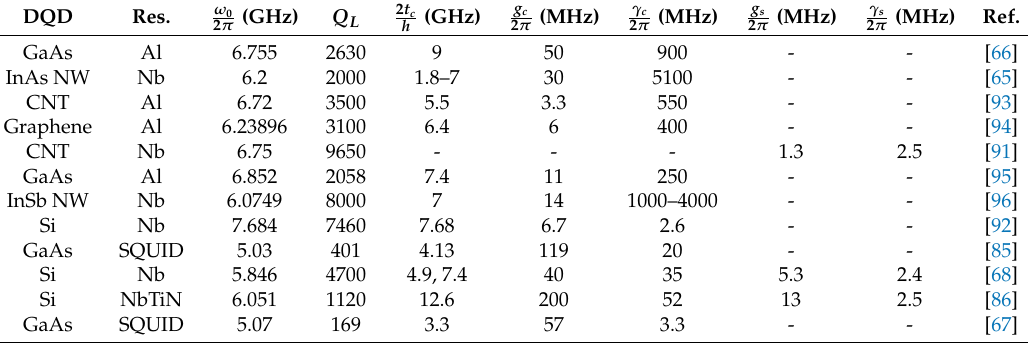
Table 1. Summary of the typical parameters reported for different DQD devices coupled to superconducting planar resonators. DQD Res. ω 0 (GHz) Q L 2 t c (GHz) g c 2 π 2 π h